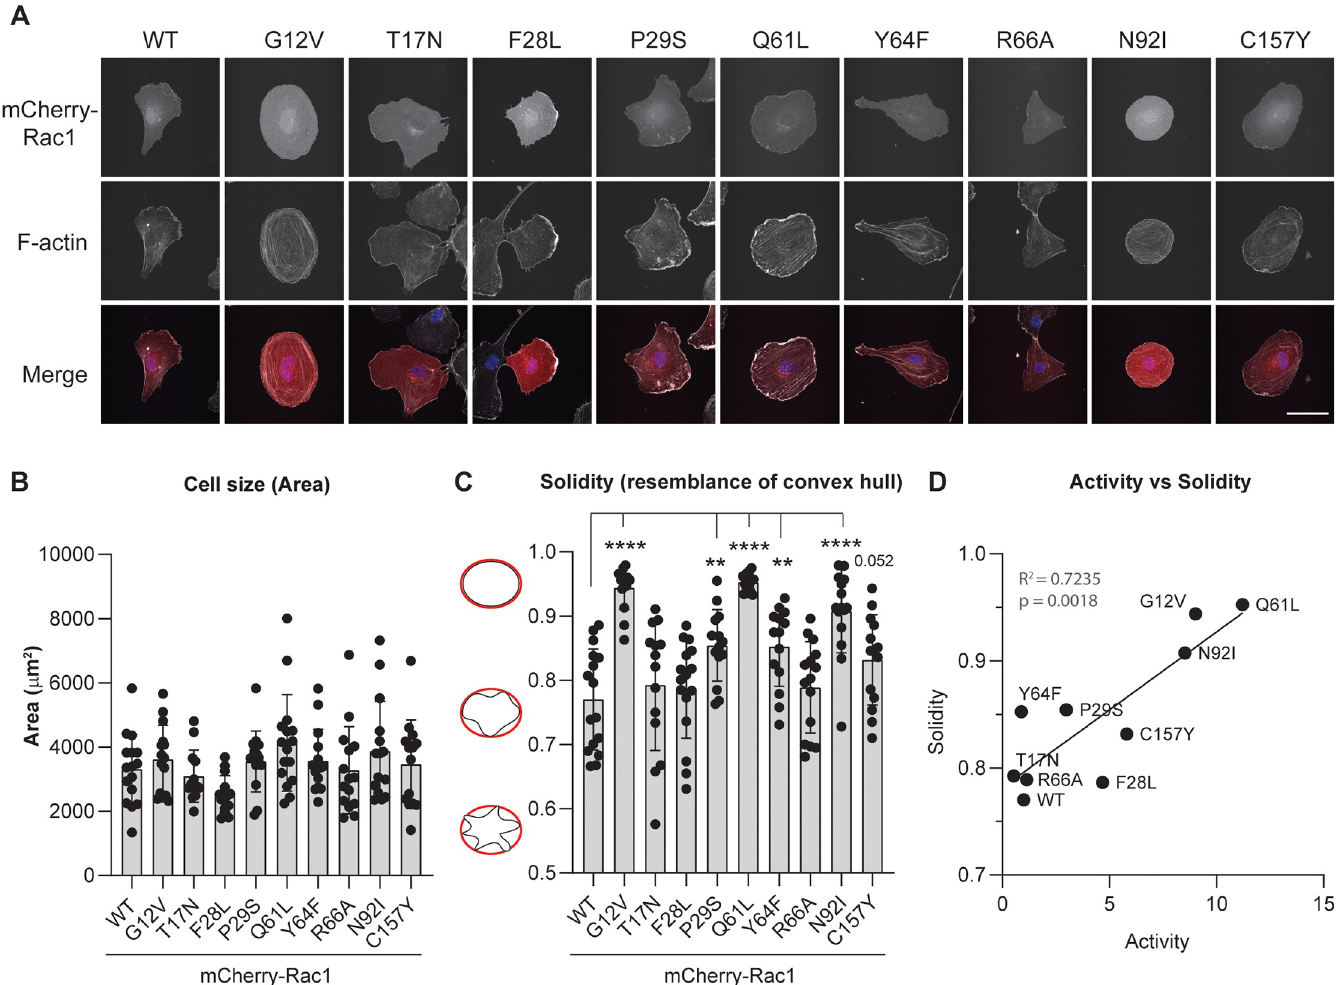
Fig 4. Rac1 G12V, Q61L and N92I mutants induce comparable morphology change in HUVECs. A) Immunofluorescent analysis of mCherry (red) and F-actin (gray) of HUVECs with transient overexpression of mCherry-Rac1 and mutants. Scale bar represents 50 μ m. B) Quantification of cell size defined by surface area covered. C) Quantification of cell shape solidity of > 20 cells per sample. �� p < 0.01 and ���� p < 0.001 compared to WT in Holm-Sidak’s post-hoc test of one-way ANOVA. D) Correlation graph with linear regression of the solidity versus activity levels of mCherry-Rac1 activating mutants.